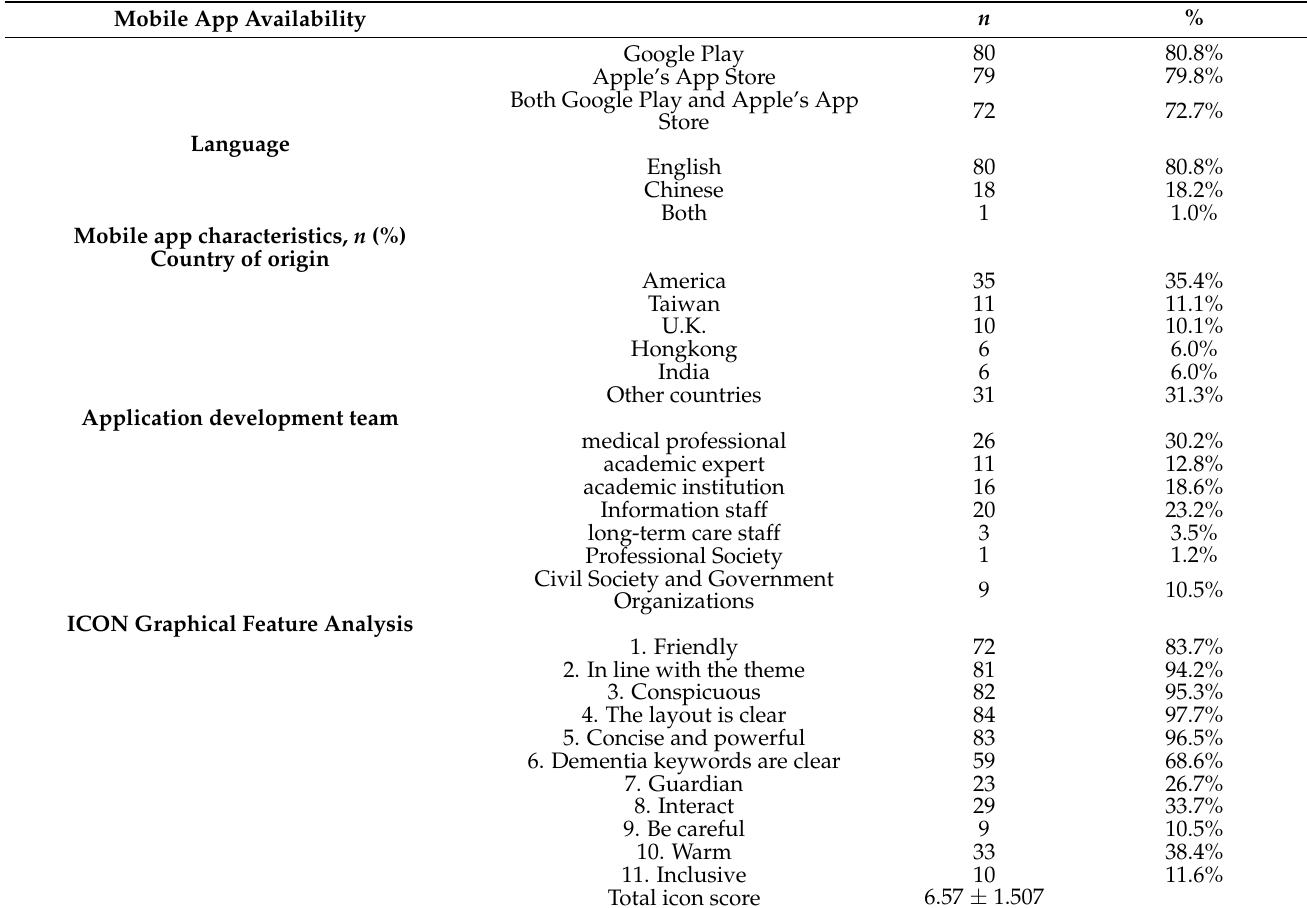
Table 1. App availability, readability, characteristics, and features. ( n =